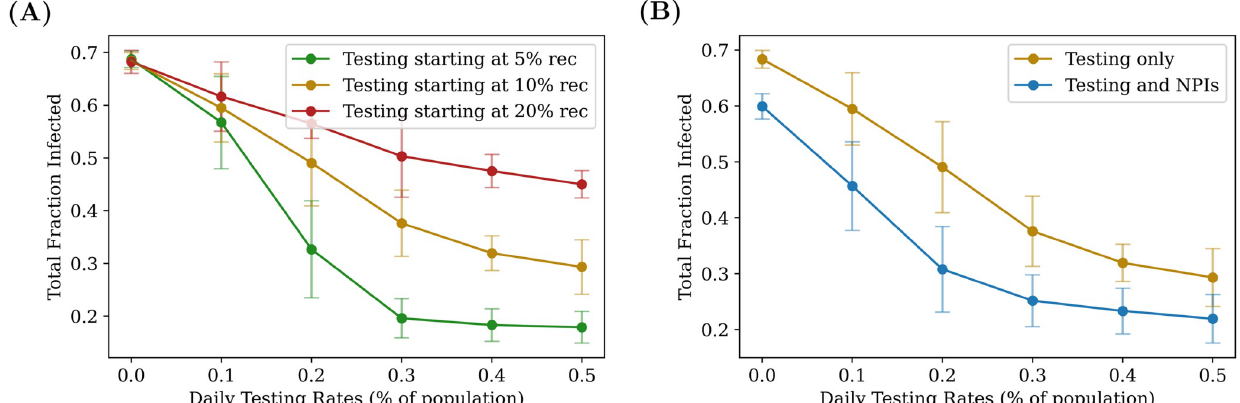
Fig 13. Synergy between NPIs and testing. Comparing the effects of two different types of interventions, given an RAT sensitivity of 75%, and an RAT: PCR ratio of 80:20. On the left, the total number of people recovered is plotted as function of daily testing rate: for a later start, testing has a weaker effect, and there exists a “threshold” (here roughly 0.3%, for the green curve) beyond which diminishing returns are gained from increasing testing. On the right, testing with and without NPIs are compared, when the interventions are both turned on when 10% of the population have recovered. NPIs are assumed to bring about a global reduction of 8% in the transmission parameter λ S . The fact that the two curves initially separate as daily testing rate is increased, shows that the two interventions act in synergy (see also S7 Appendix). As before, the plots were obtained by averaging over 100 simulation runs of 200 days each.